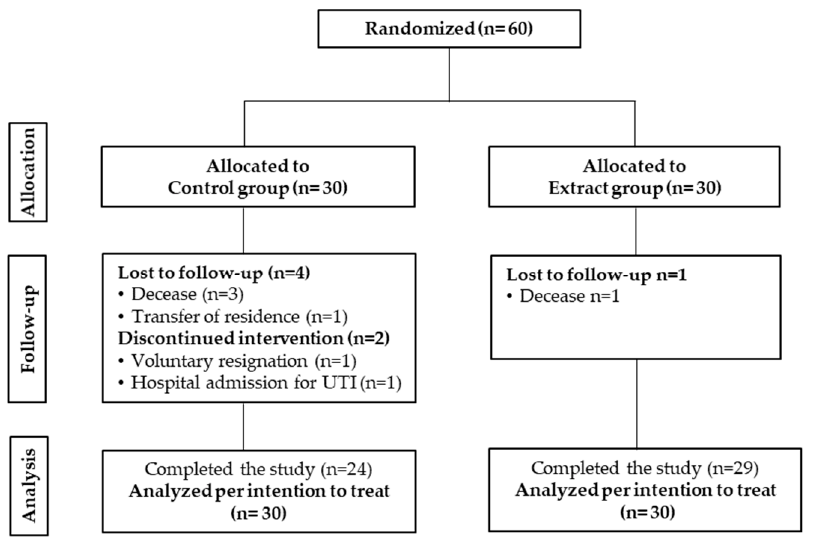
Figure 1. Diagram of the Consolidated Standards of Reporting Trials.